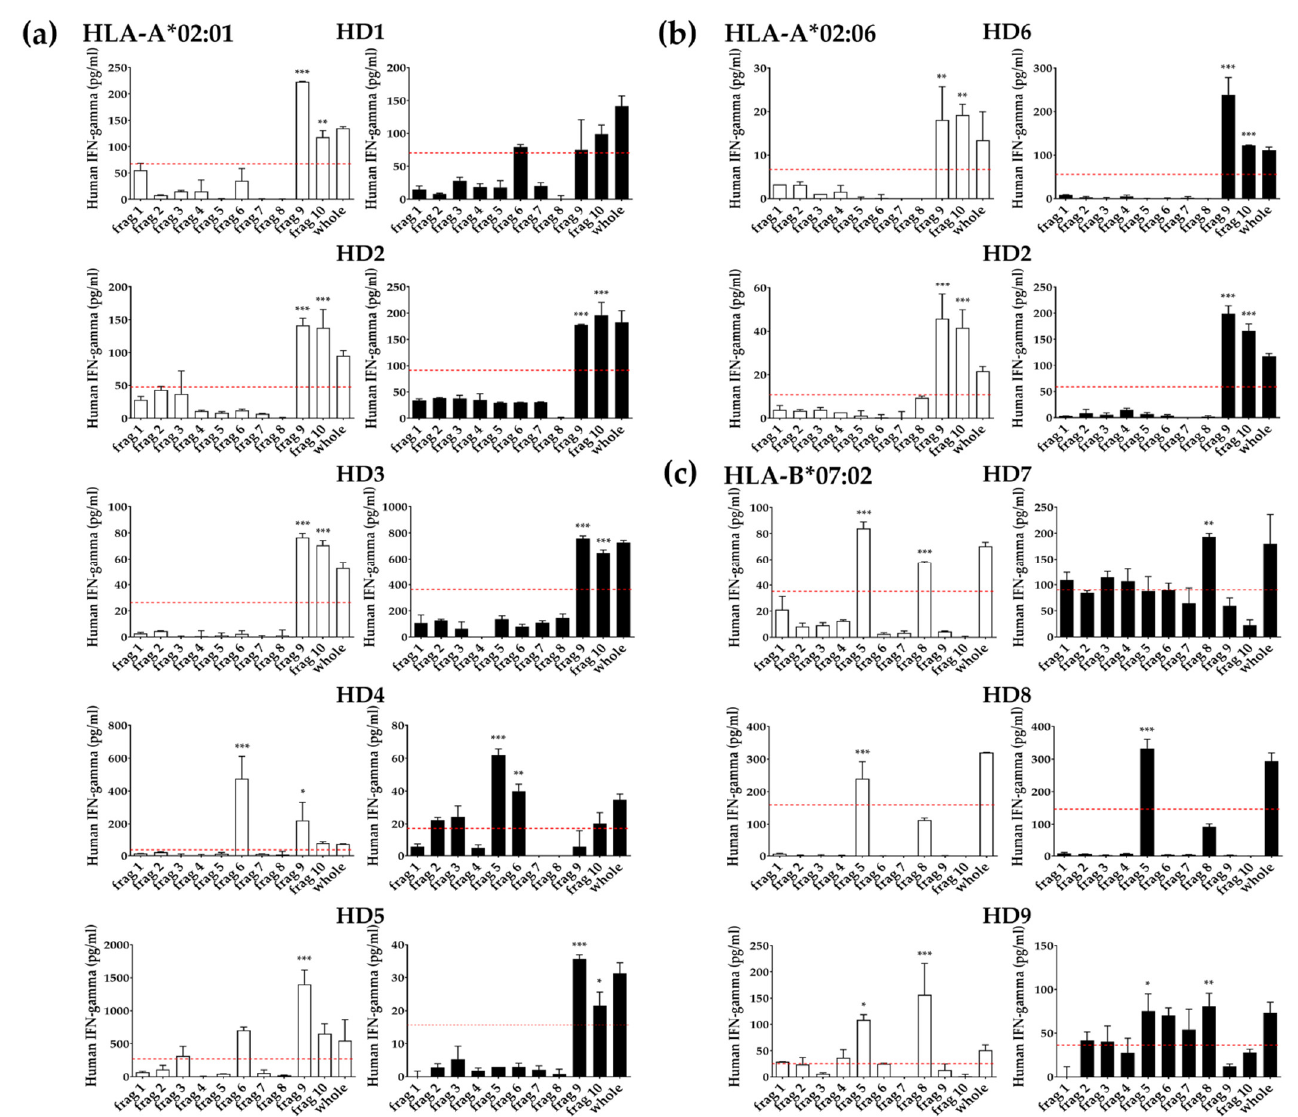
Figure 4. Identification of epitope regions using aAPCs expressing pp65 fragment antigens. PBMCs (white bar) and expanded T cells (black bar) of each donor were co-cultured with aAPCs expressing a single HLA class I allotype such as ( a ) HLA-A*02:01, ( b ) HLA-A*02:06, and ( c ) HLA-B*07:02 and pp65 whole or fragment antigens at a ratio of 10:1 for 24 h and the level of IFN-γ in the culture supernatants was measured by ELISA. Red dotted line; positive cut-off value. All experiments were performed in triplicate and repeated at least twice. Representative data are shown. Error bars show mean values ± SD of triplicate. p value was calculated by one-way ANOVA. *; p < 0.05, **; p < 0.005, ***; p <